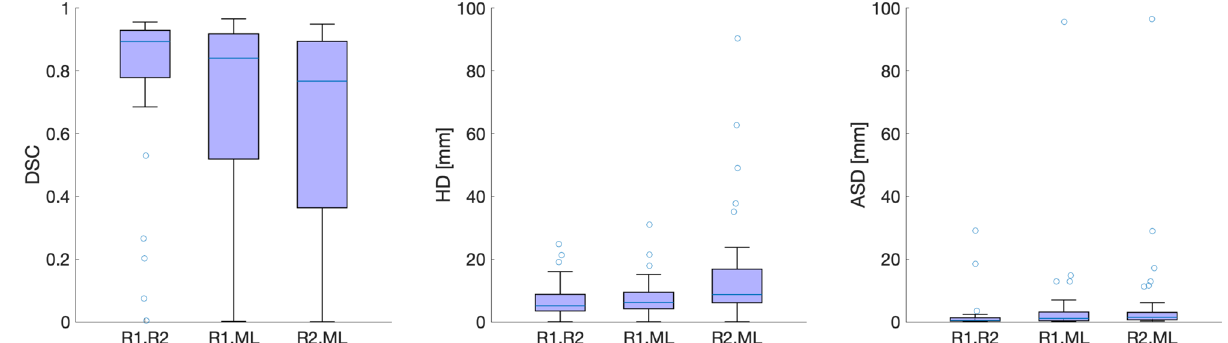
Figure 5. Box plot of DSC, HD, and ASD obtained when comparing segmentations between raters and ML. Left plot: Median DSC obtained for inter-rater agreement (left box: R1, R2) is higher than between raters and ML (middle and right boxes). Middle plot: The lowest median HD was obtained for inter-rater agreement (left box: R1, R2), followed by ML with both of the raters (middle and right boxes). Right plot: The lowest median ASD was obtained for inter-rater agreement (left box: R1, R2), followed by ML with both of the raters (middle and right boxes). R = rater.